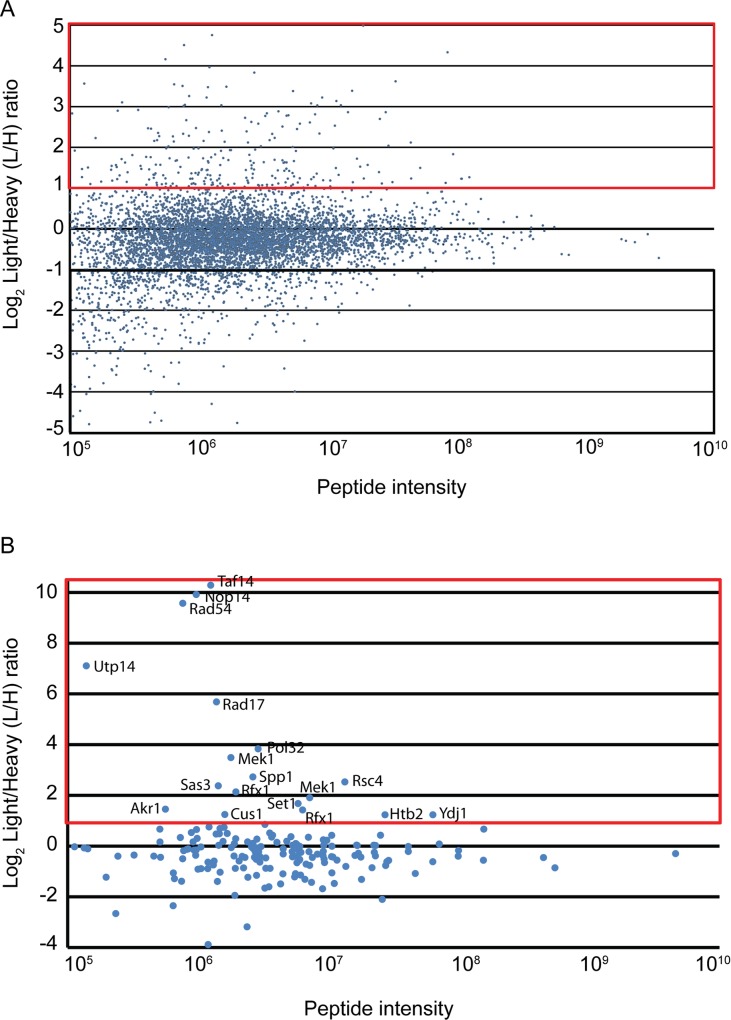
Integrated light/heavy (L/H) ratios of phosphopeptides obtained from the merged non-redundant phosphopeptide datasets from two SILAC experiments using a dmc1Δ mek1-as diploid.(A) L/H ratios of phosphorylated peptides are plotted on a log2 scale (Y-axis) as a function of peptide intensity (X-axis). The red box indicates Class 1 peptides with L/H ratios > 2.0, while the black box indicates Class 3 peptides with L/H ratios < 0.5. Peptide intensity is a measure of how well each peptide is ionized and subsequently detected by the MS and is correlated to the quantity of each peptide in the sample. Highly abundant peptides will display peptide intensities with large signal to noise ratios and therefore have more accurate L/H ratios when compared to lower abundance peptides with signal to noise ratios closer to 1. L/H ratios were calculated by dividing the integrated peptide intensities of light and heavy peptides. Integrated peptide intensities are defined as the area under the curve of the peptide elution peak. (B) The L/H ratios of 175 RXXT phosphopeptides were plotted on a log2 scale (Y-axis) as a function of peptide intensity (X-axis). The red box indicates peptides that are >2-fold enriched in the Light (Mek1 active) culture. The name indicates the protein from which the phosphopeptide was derived.